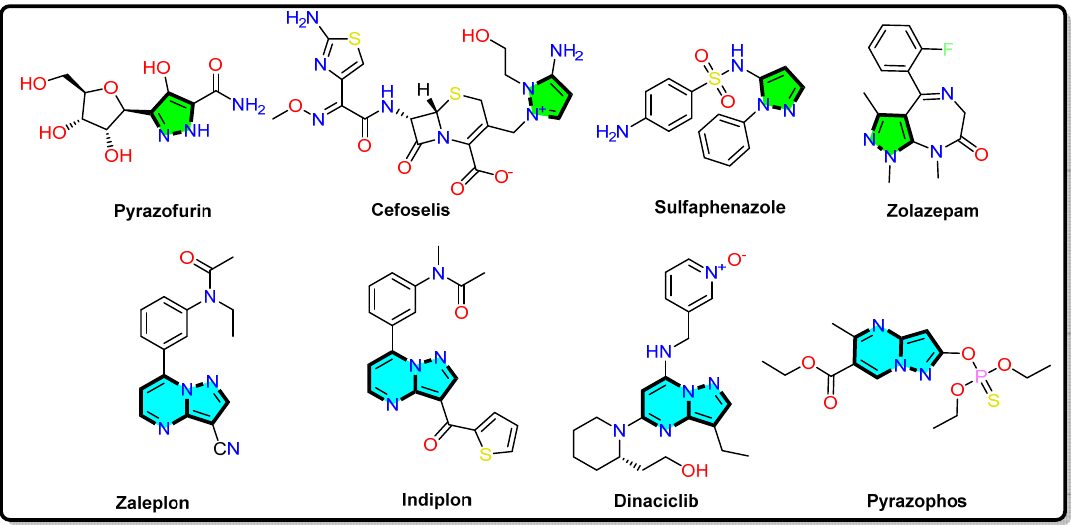
Figure 1. Structures of drugs containing pyrazole and pyrazolo[1,5- a ]pyrimidine nucleus.